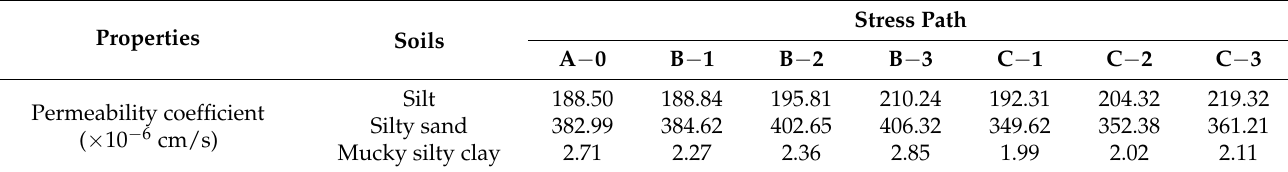
Table 8. Permeability coefficient of soil.